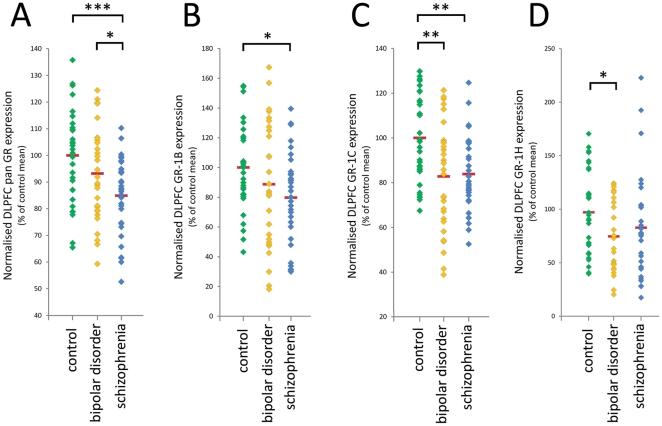
Expression of pan GR, GR-1B, GR-1C and GR-1H mRNA transcripts in the DLPFC.Control, bipolar disorder and schizophrenia cases from the Stanley Array cohort were used. A) Pan GR mRNA expression was 15.1% lower in schizophrenia cases relative to controls (p<0.0005), and 8.9% lower in schizophrenia cases relative to bipolar disorder cases (p<0.05). B) GR-1B mRNA expression also differed significantly between diagnostic groups, with 20.2% lower GR-1B expression in schizophrenia cases than controls (p<0.05). C) GR-1C mRNA expression was significantly decreased in schizophrenia (16.1%) and bipolar disorder (17.2%) cases relative to controls (both p<0.005). D) A significant effect of diagnosis GR-1H expression was not observed, but a planned post-hoc test revealed a significant difference between bipolar disorder and control groups (p<0.05). Green, orange and blue diamonds represent control, bipolar disorder and schizophrenia cases respectively. Red bars represent group means. * p<0.05, ** p<0.005, *** p<0.0005.